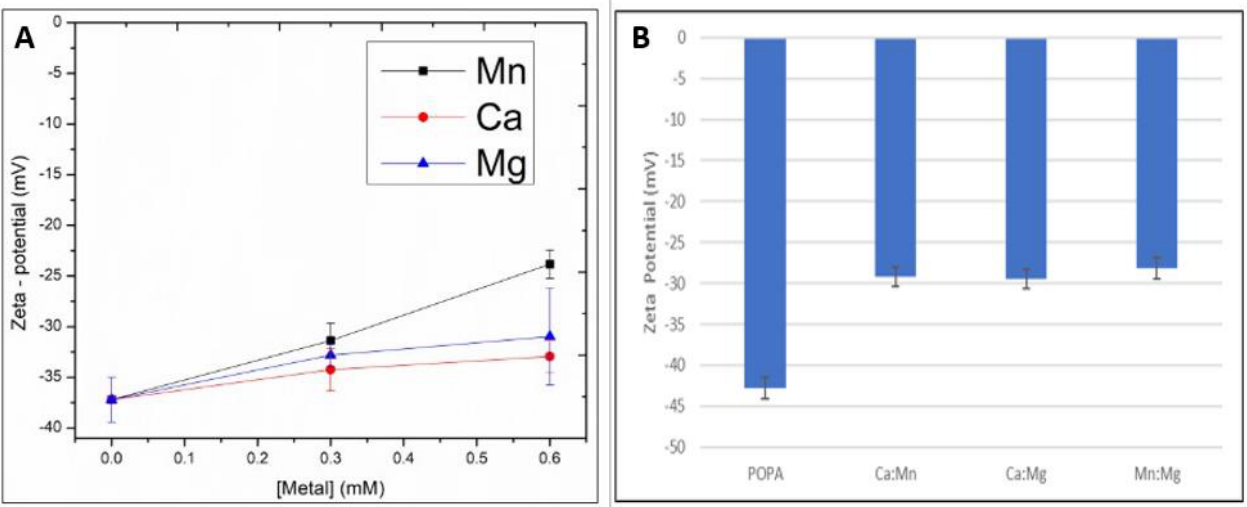
Figure 2. Zeta potential values of POPA LUVs with ( A ) the dose-dependent addition of Mn, Ca and Mg and ( B ) mixtures of Mn, Ca and Mg present in a 1:1 metal mixture to a total metal concentration of 0.3 mM. Samples were measured at 25 °C. Data are obtained as an average of three replicates ± standard deviation ( n = 3).